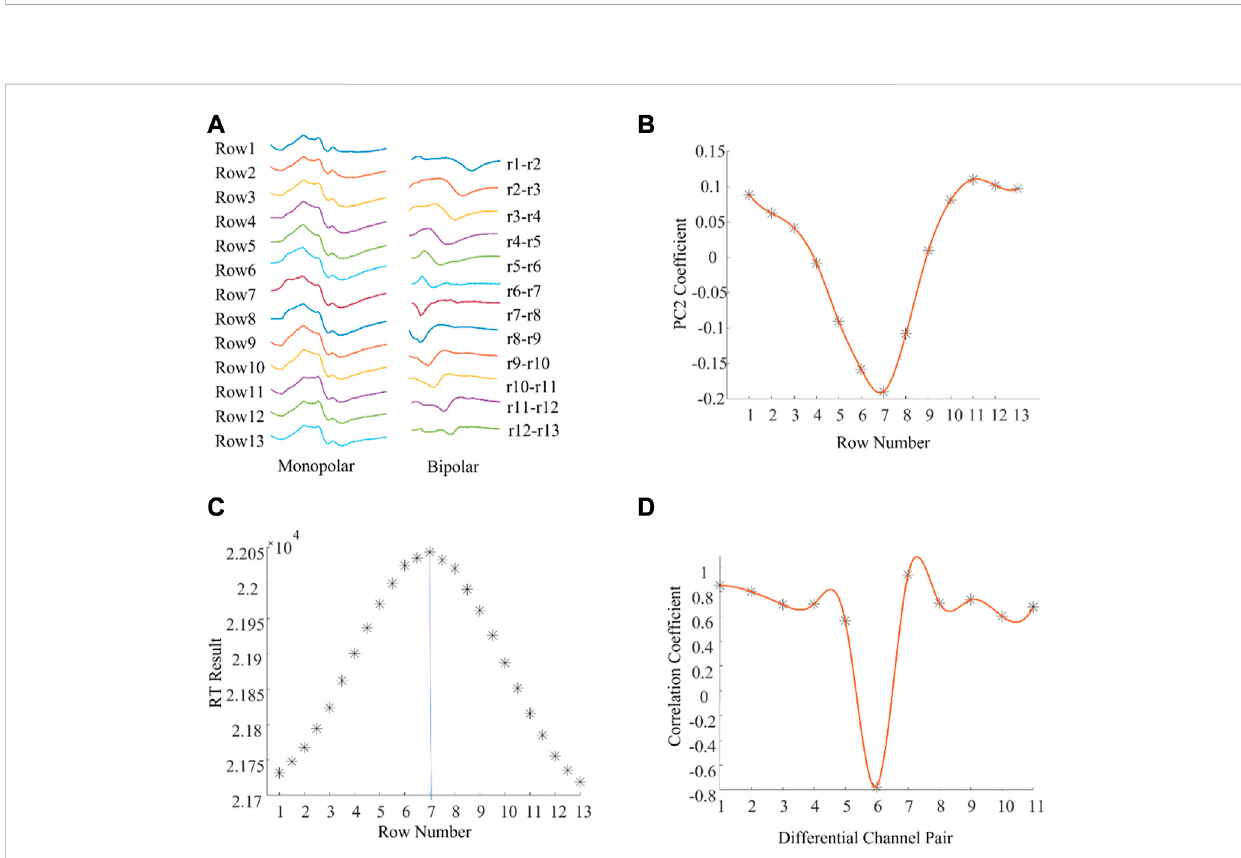
FIGURE 2 An example ofmuscle IZ estimation from experimentalhigh density Mwaves where differentmethods reached thesameresults. (A) :AcolumnofM waves of a tested subject. (B) : PCA based IZ estimation: the minimum coef fi cient was located at row 7 and the coef fi cients gradually increased along the fi berdirection. (C) :RTbasedIZestimation:thedistributionofRTresultsacrossalltherows,andbetweenrows. (D) :CrosscorrelationbasedIZestimation: the distribution of the correlation coef fi cients between adjacent bipolar